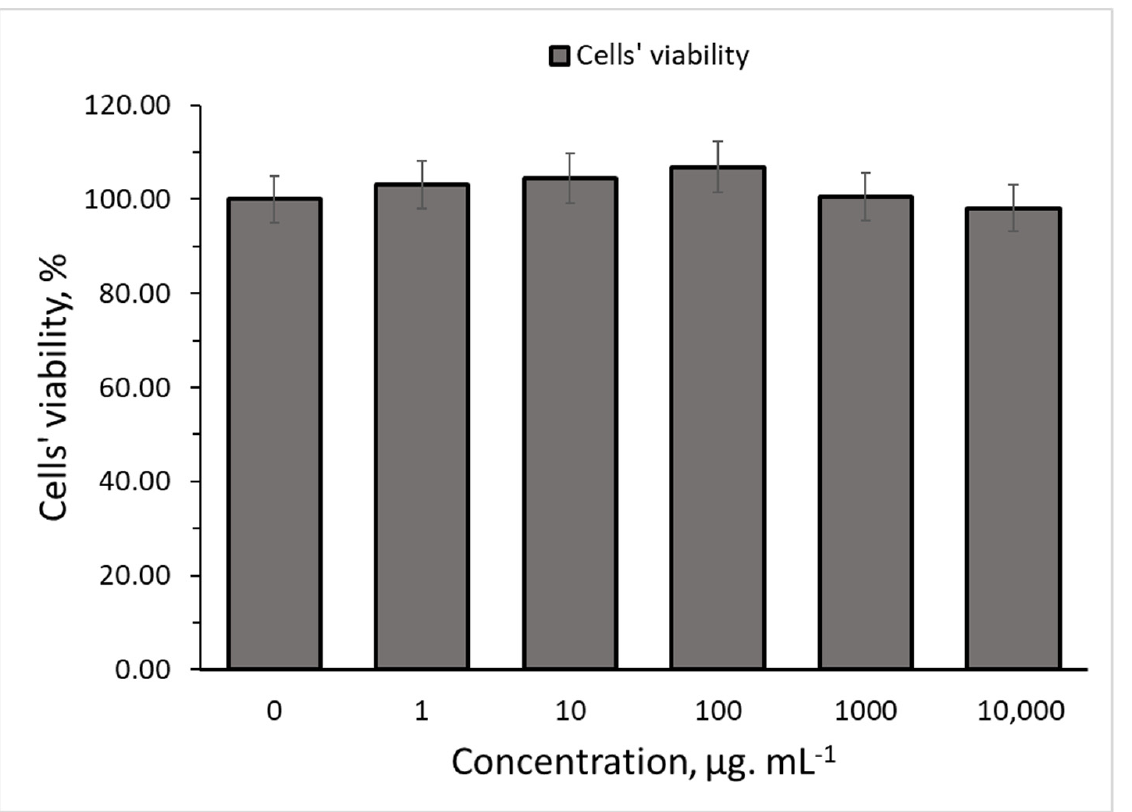
Figure 6. Cell viability of fibroblast cells (HSF 1184) cultured with increasing concentrations of NE-FLO using the MTT assay. Data are presented as mean ± SD ( n = 3). Control is the cell treated with DMEM only.